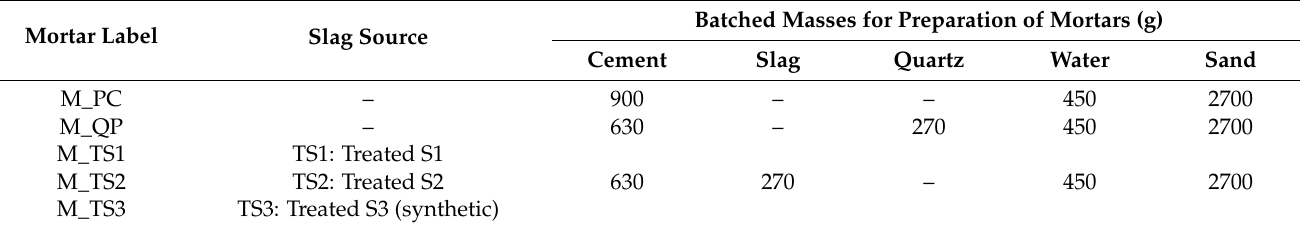
Table 6. Batched masses of produced mortar mixtures for strength activity and strength development tests. Batched Masses for Preparation of Mortars Mortar Label Slag Source